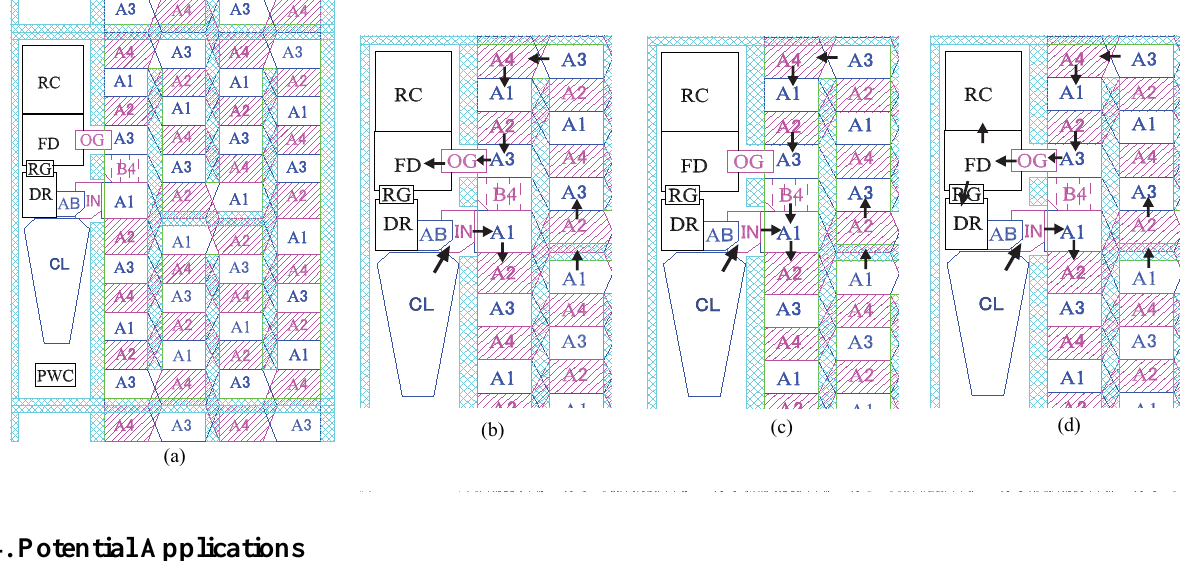
Figure 12. Operation of Hybrid CCD/CMOS ISAS: (a) Plan of a pixel; (b) Continuous overwriting mode; (c) Signal accumulation (ISAS) mode; (d) Readout mode. For abbreviation definitions, see Appendix